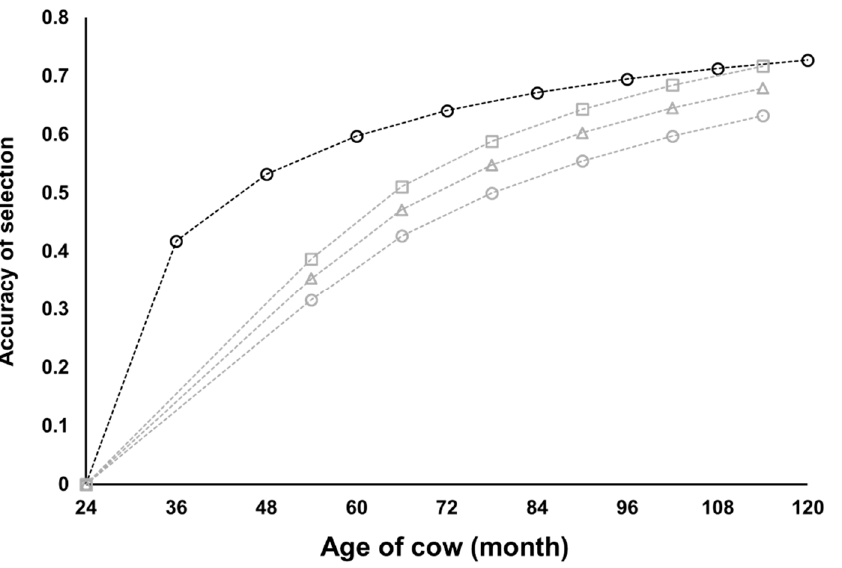
Figure 7. Expected accuracies of selection of cows for calving interval based on their own performance and for carcass traits based on carcass performance of their progenies. Black circles show accuracy of selection for calving interval when the true heritability and repeatability correspond to the values estimated by repeatability model analysis in this study. Gray circles, triangles, and squares show accuracy of selection for carcass traits when true heritability is 0.4, 0.5, and 0.6, respectively.